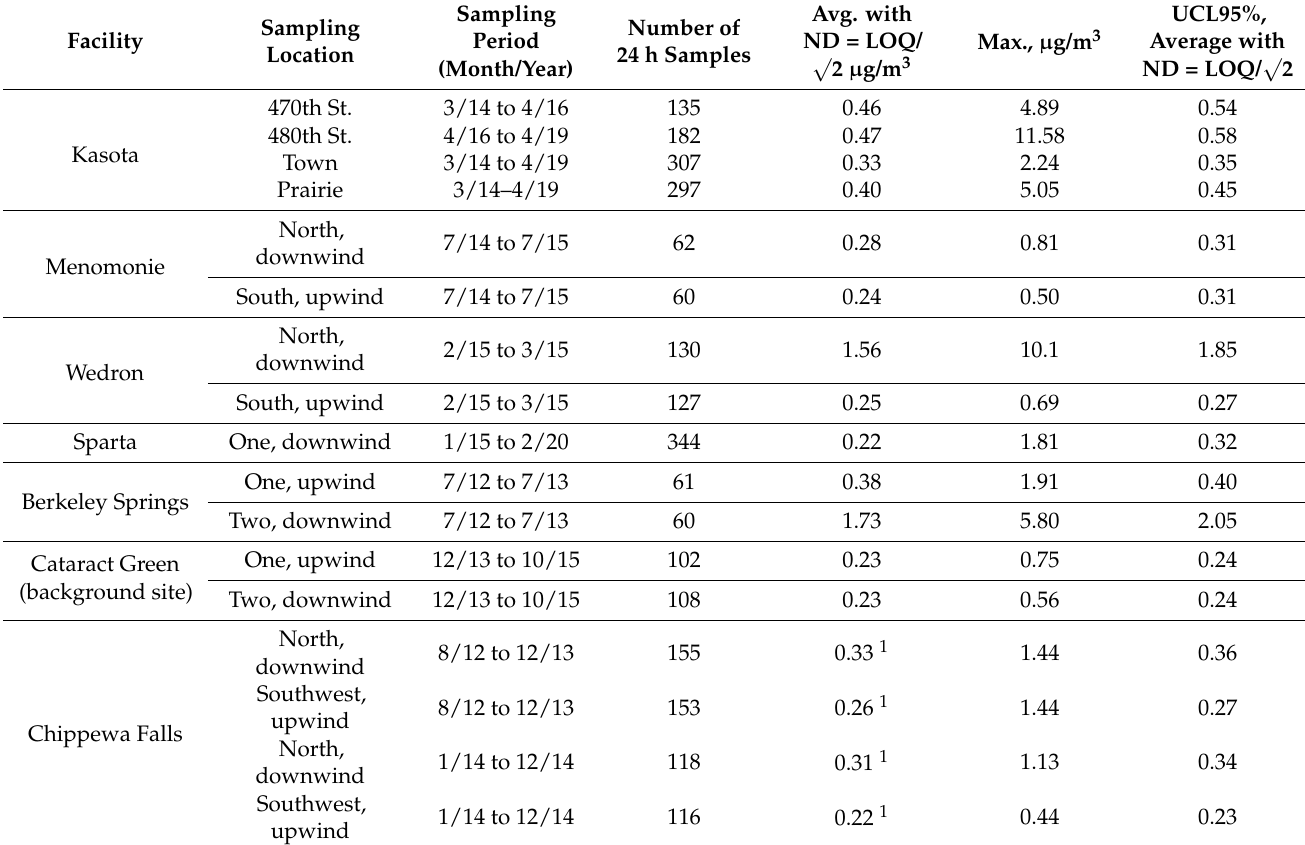
Table 3. Ambient PM 4 respirable crystalline silica concentration